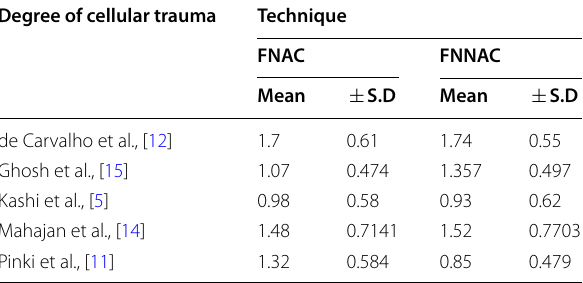
Table 7 Samples scores [5] Criteria FNAC